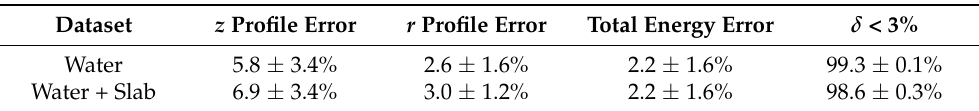
Table 1. Results on energy deposition reconstruction . We report mean relative errors on energy profiles and total energy along with the mean 3% δ -index passing rate. Uncertainties are computed as standard deviations. Values are computed on test sets.